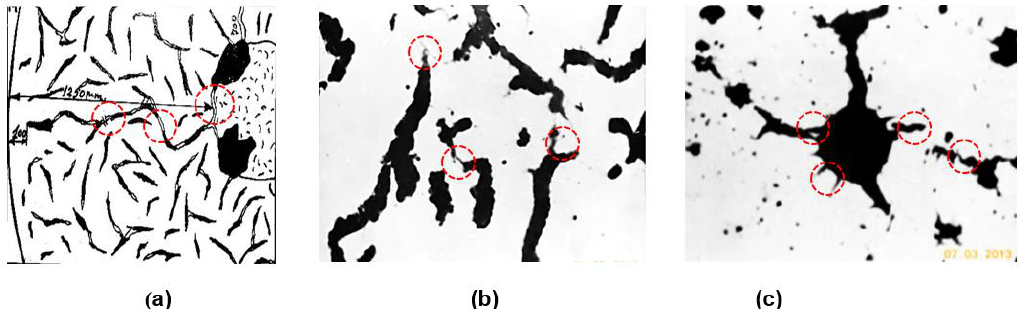
Figure 1. Micro-cracks developed on the tip of the lamellar ( a ) and vermicular/compacted ( b ) graphite particles and on the surface of irregularly shaped graphite nodules ( c ) as a result of the thermal-shock test. The red circle shows the micro-crack initiation.